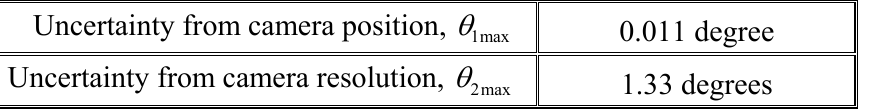
Table 2. Uncertainties in the experiment.